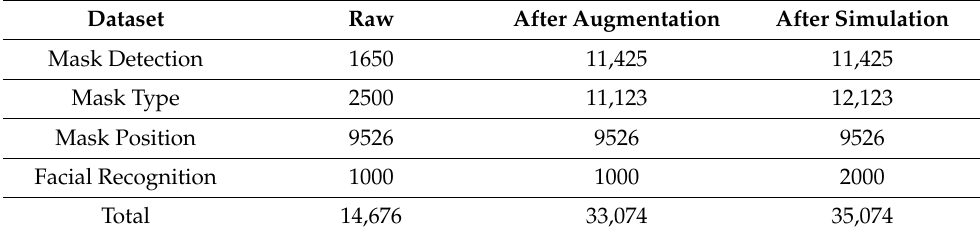
Table 3. Image Numbers for Each